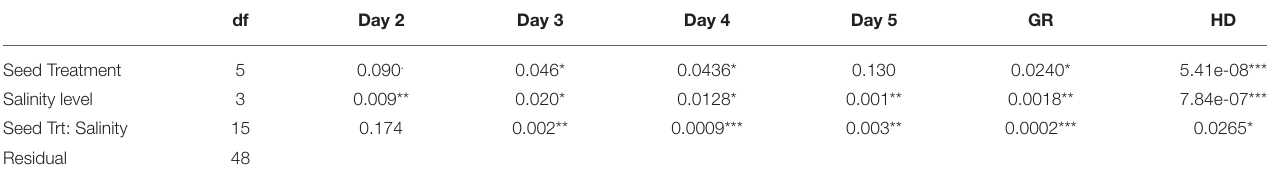
TABLE 2 | Means and SD of Phaseolus vulgaris germination rate (GR) in percent under different seed treatments and salinity levels. Salinity levels Control R. tropici Trehalose Coating Means S0 87 ± 9 a 87 ± 9 abc 80 ± 16 cd 87 ± 9 abc